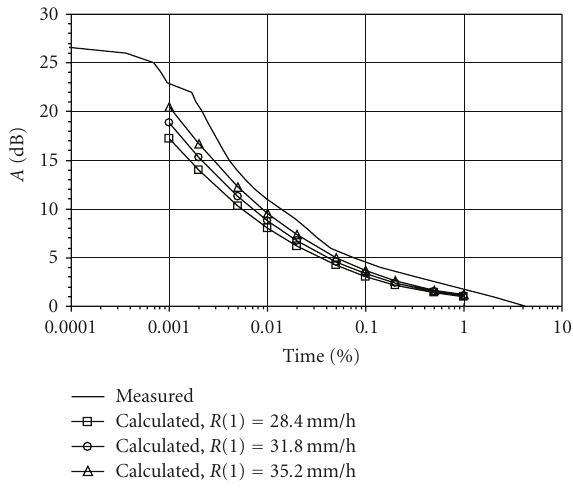
Figure 14: Comparison of obtained CD of attenuation due to rain and calculated CDs of attenuation due to